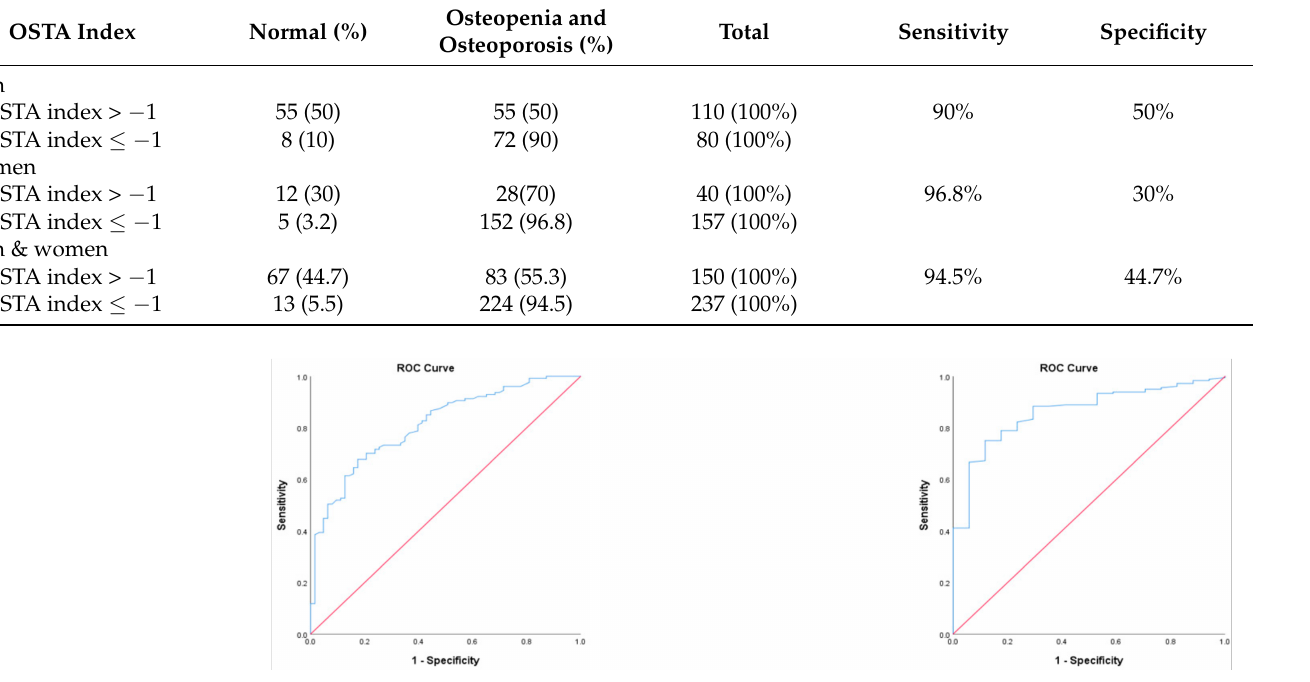
Figure 3. The receiver operating characteristics (ROC) curves for the Osteoporosis Self-Assessment Tool for Asians (OSTA) values in men and women. There were significant differences between the OSTA values and cutoff of t-score ≤ − 1.0 on quantitative ultrasound (QUS) ( p < 0.001) in men and women. The areas under the curve in men and women were 0.812 (95% confidence